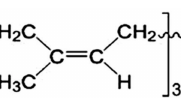
Figure 1. Chemical formula of epoxidized natural rubber